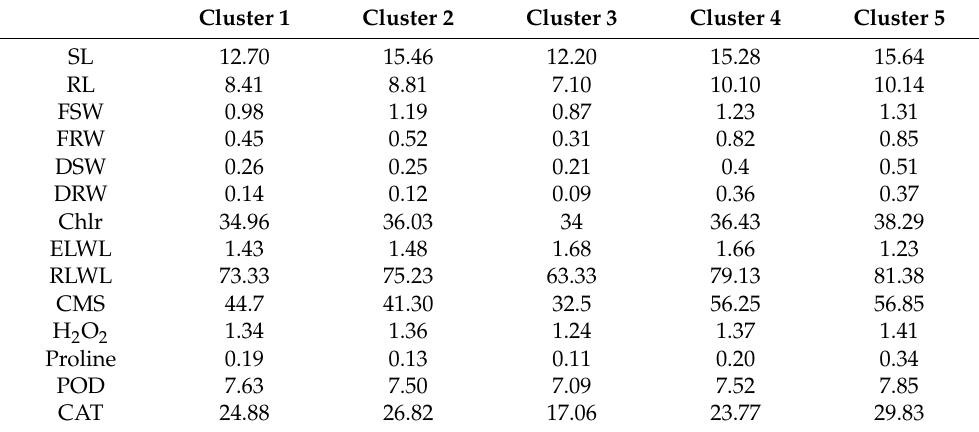
Table 4. K-means cluster analysis of 50 cotton genotypes grown under control